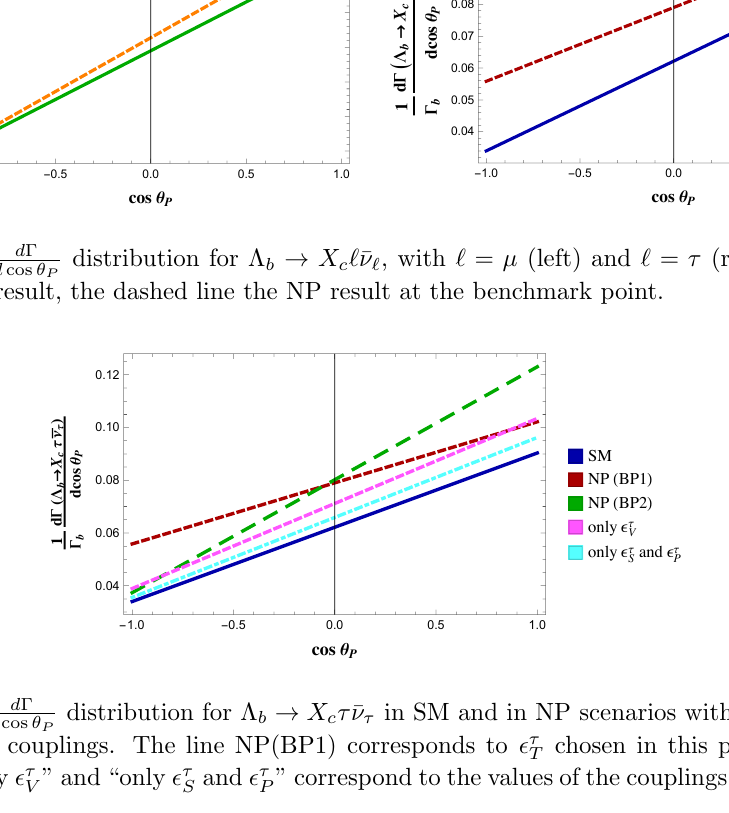
chosen in this paper. The lines T